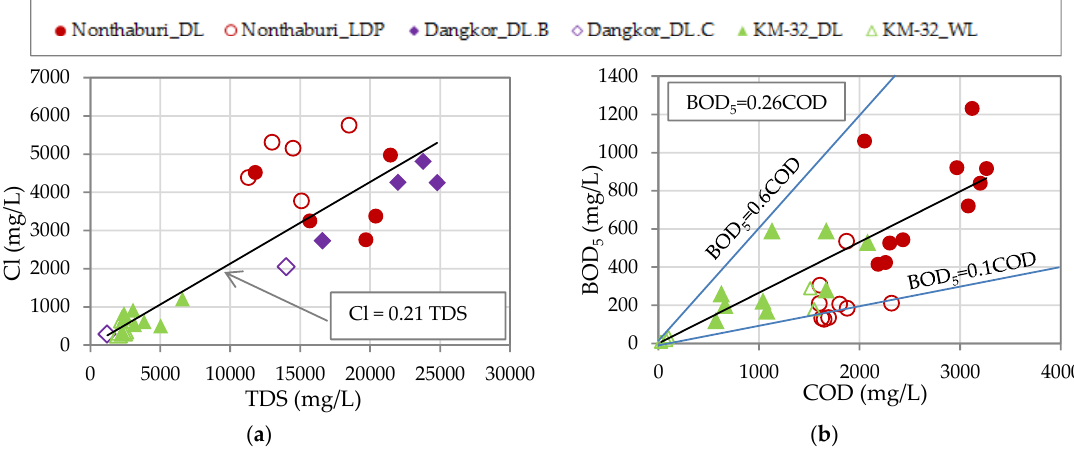
Figure 4. ( a ) Relationship between Cl and TDS; ( b ) Relationship between BOD 5 and COD.